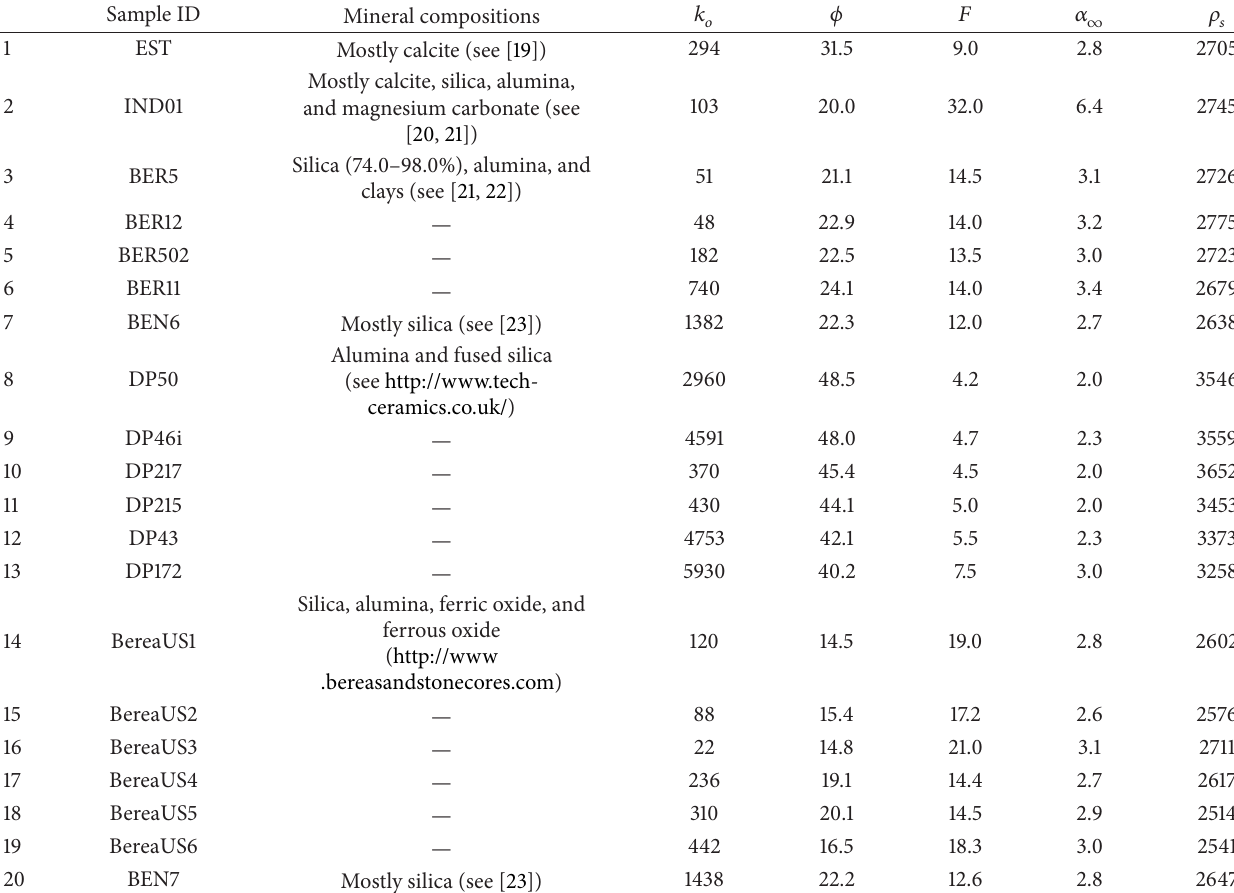
Table 1: Sample ID, mineral compositions, and microstructure parameters of the samples. Symbols 𝑘 𝑜 (in mD), 𝜙 (in %), 𝐹 (no units), 𝛼 ∞ (no units), and 𝜌 𝑠 (in kg/m 3 ) stand for permeability, porosity, formation factor, tortuosity, and solid density, respectively. For lithology, EST stands for Estaillade limestone, IND stands for Indiana Limestone, BER and BereaUS stand for Berea sandstone, BEN stands for Bentheim sandstone, and DP stands for artificial ceramic